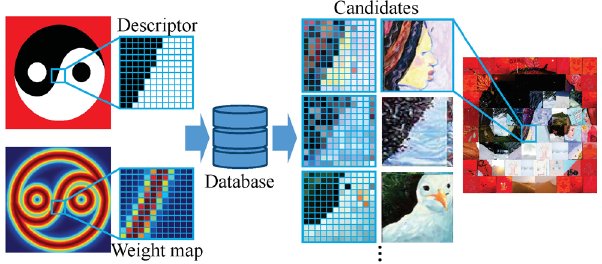
Fig. 3 Edge-aware image retrieval